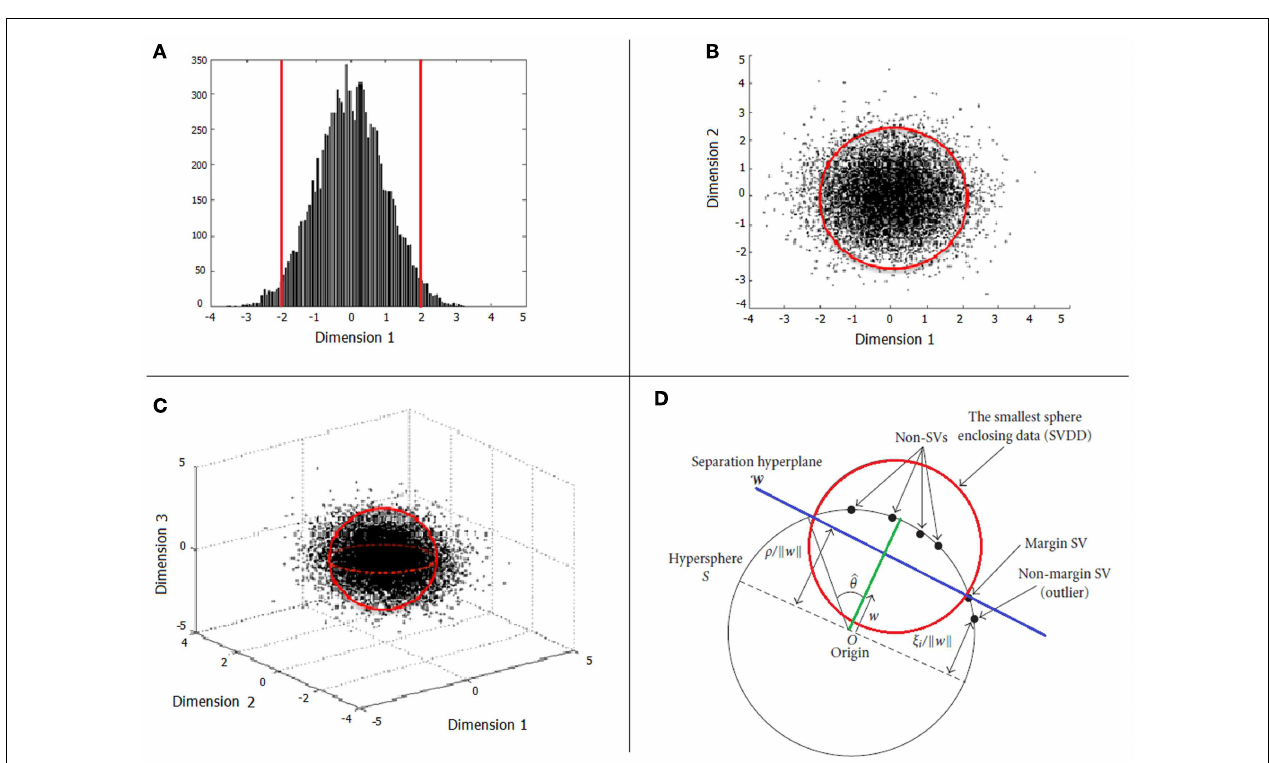
FIGURE 1 | Examples of boundary specification in the cases of one (A), two (B), and three (C) input variables. Illustration of OC-SVM concepts are depicted in (D) .